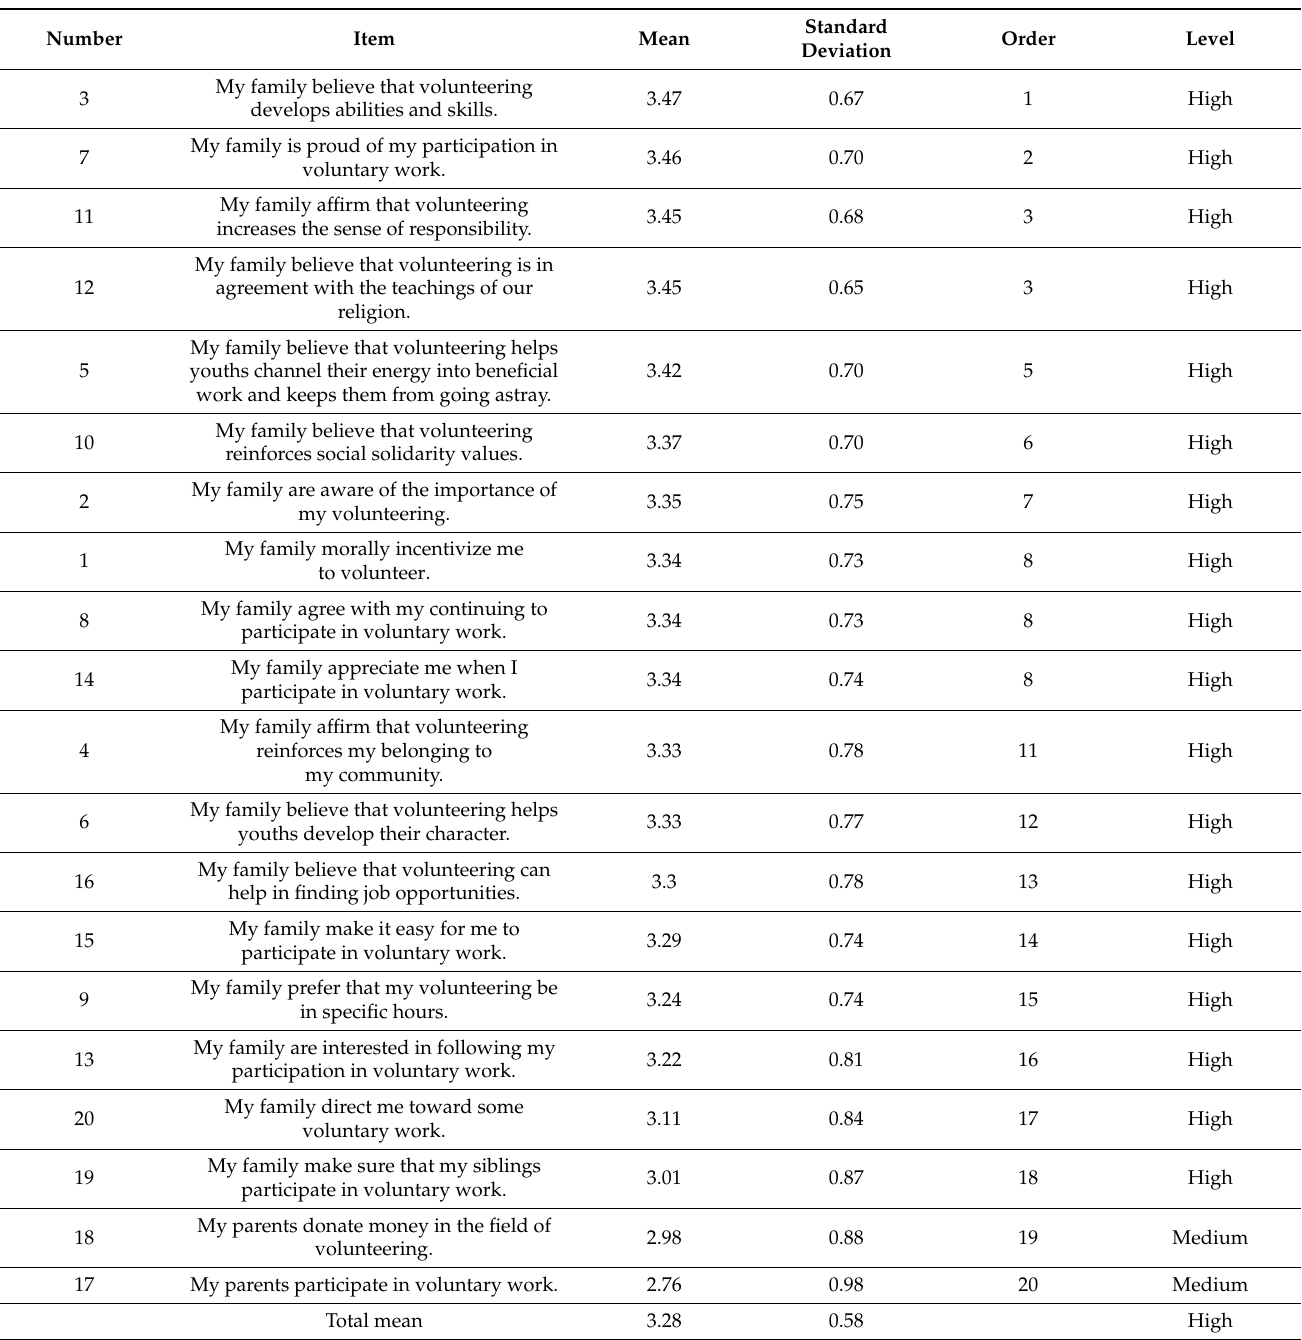
Table 3. Means and standard deviations of the responses of the study’s participants to the items included in “the familial factors that reinforce volunteering culture in youth,” listed in descending order by